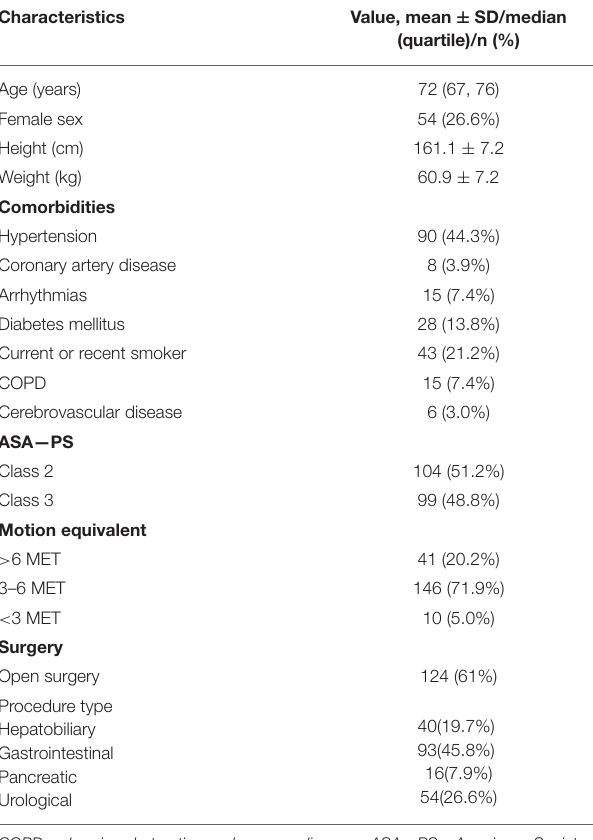
TABLE 1 | Participant baseline characteristics and type of surgery ( n = 203). Characteristics